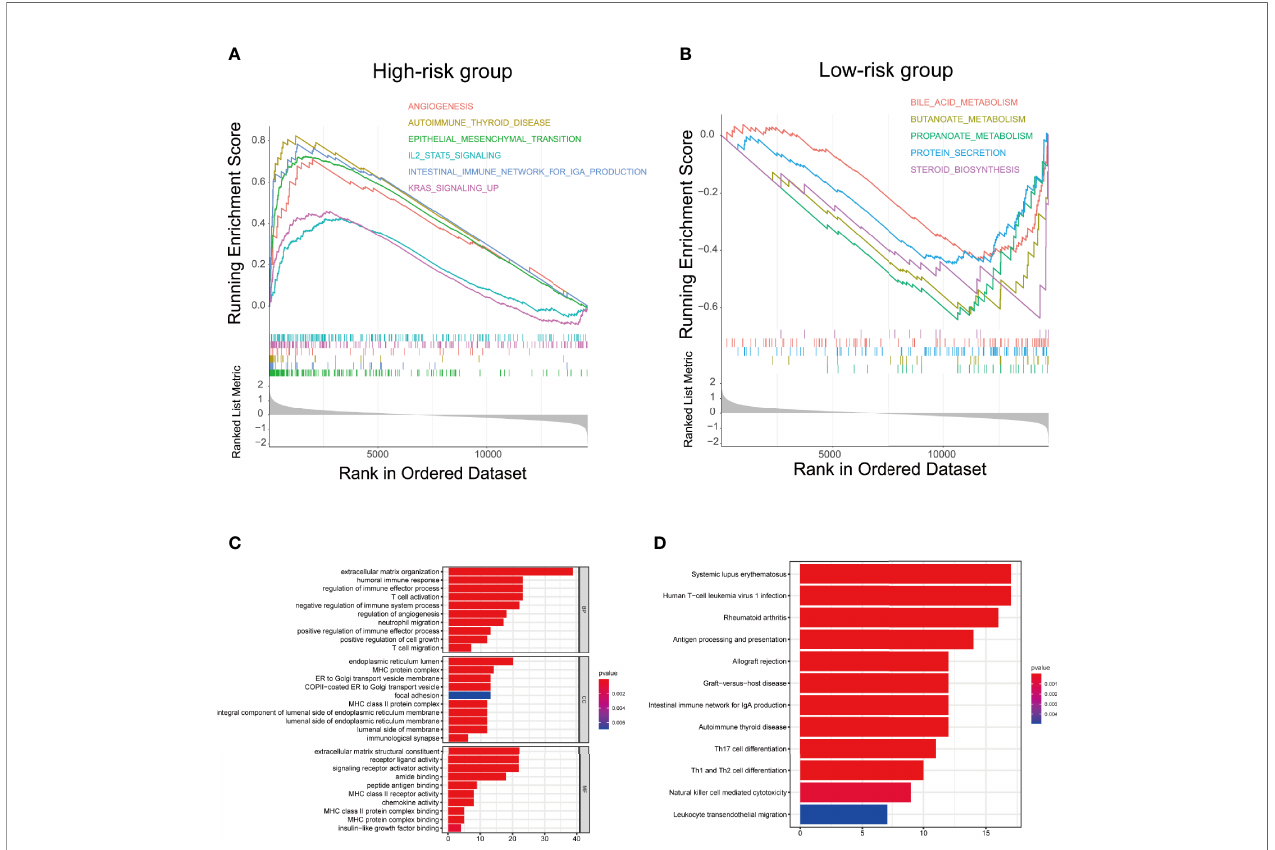
FIGURE 6 | Biological functional and pathway enrichment analysis of high-risk group and low-risk group based on the ferroptosis-related lncRNA prognostic signature. (A) GSEA showing signi fi cant enrichment of immune-related pathways and cancer proliferation pathways in the high-risk colon cancer patients. (B) GSEA showing signi fi cant enrichment of metabolism related pathways in the low-risk colon cancer patients. (C) GO analysis showing many immune-related biological processes were enriched. (D) KEGG analysis showing many immune-related pathways and cancer proliferation pathways were